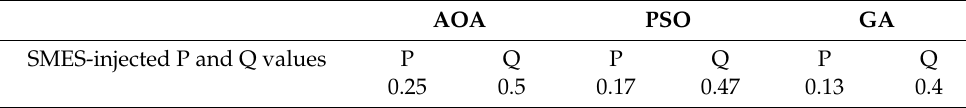
Table 11. SMES-injected active and reactive power for L-L scenario. AOA PSO GA SMES-injected P and Q